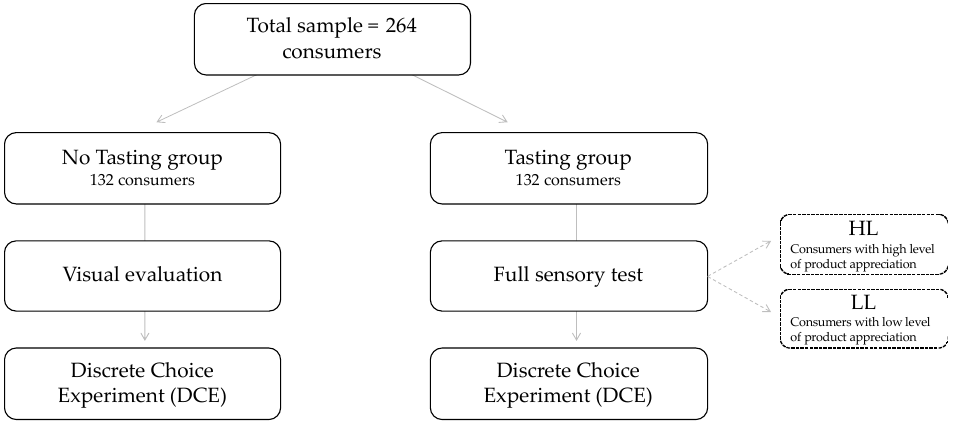
Figure 1. Experimental structure. Note: dashed rectangles represent groups defined during the data processing. HL refers to consumers in the tasting group who gave an overall liking score higher than 5 to the product sample tasted. LL refers consumers in the tasting group who gave an overall liking score equal or lower than 5 to the product sample tasted. Source: our elaboration.